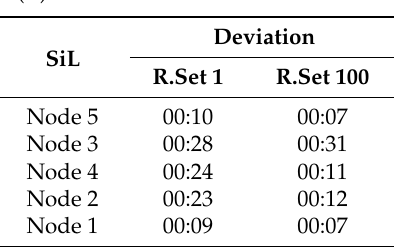
Table 4. Output tables of the temporal filter calculation task for the sample network. ( a ) SiT for all random sets. SiT SiL R.Set 1 R.Set 100 Node 5 14:30 14:10 Node 3 13:30